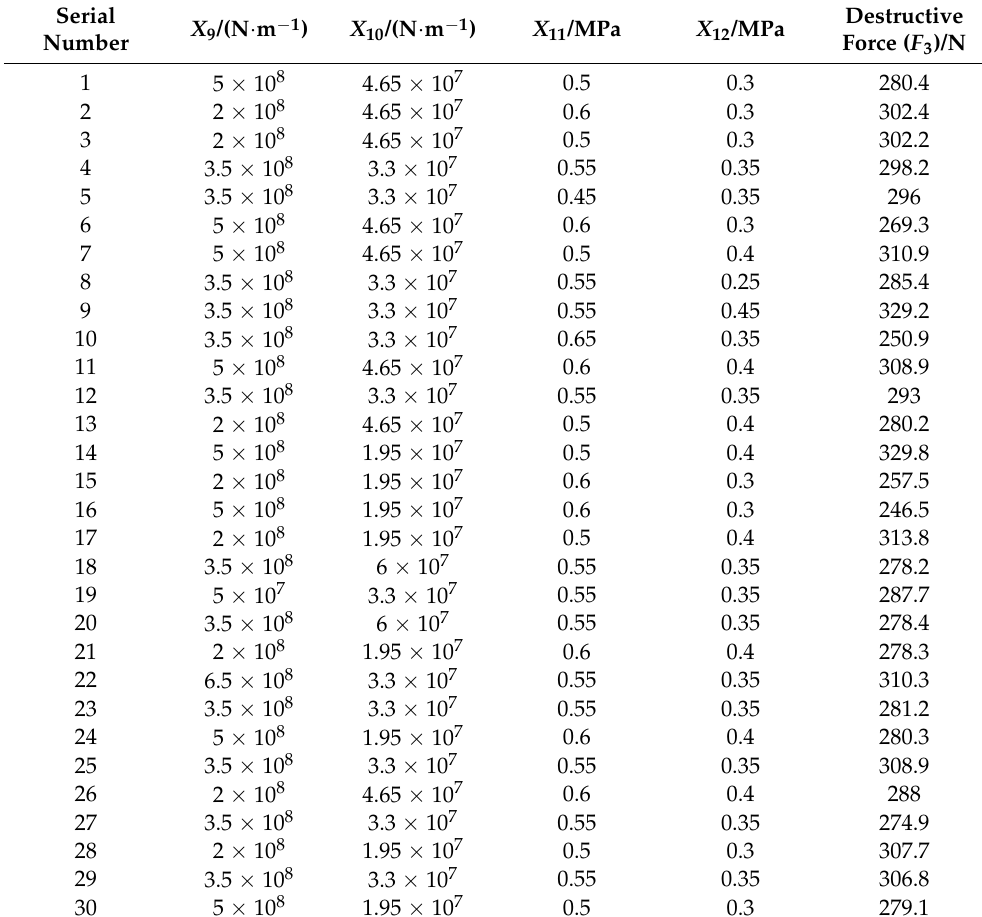
Table 10. Experimental design and results of bonding parameters between epidermis and inner